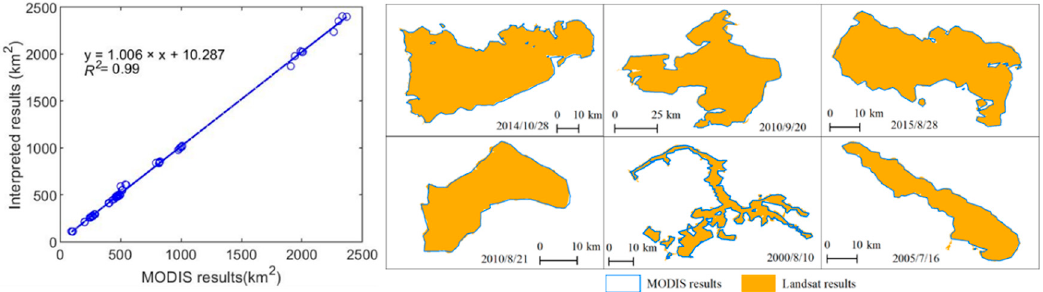
Figure 6. Comparisons between 30 m interpretation products and the extracted results based on MODIS images. MODIS images.